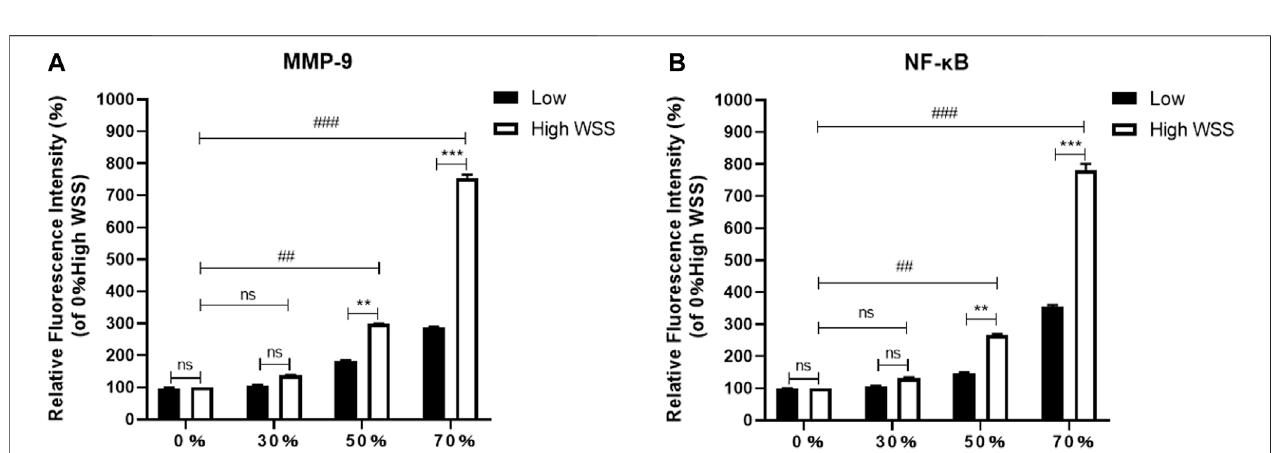
FIGURE 8 | Comparison of relative fl uorescence intensity of MMP-9 (A) and NF- κ B (B) at the high- and low-WSS regions in different stenosis models.